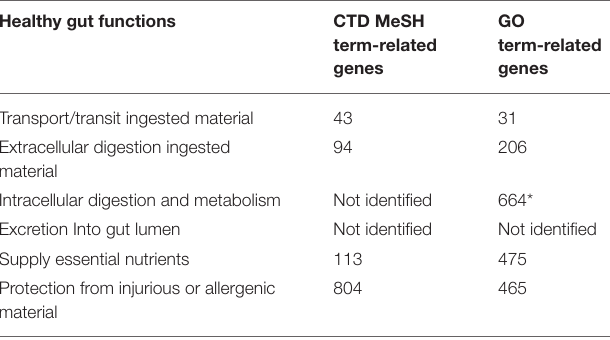
TABLE 5 | Number of identified genes that are related to a gut function using the Comparative Toxicogenomics Database (CTD) and Gene Ontology (GO)